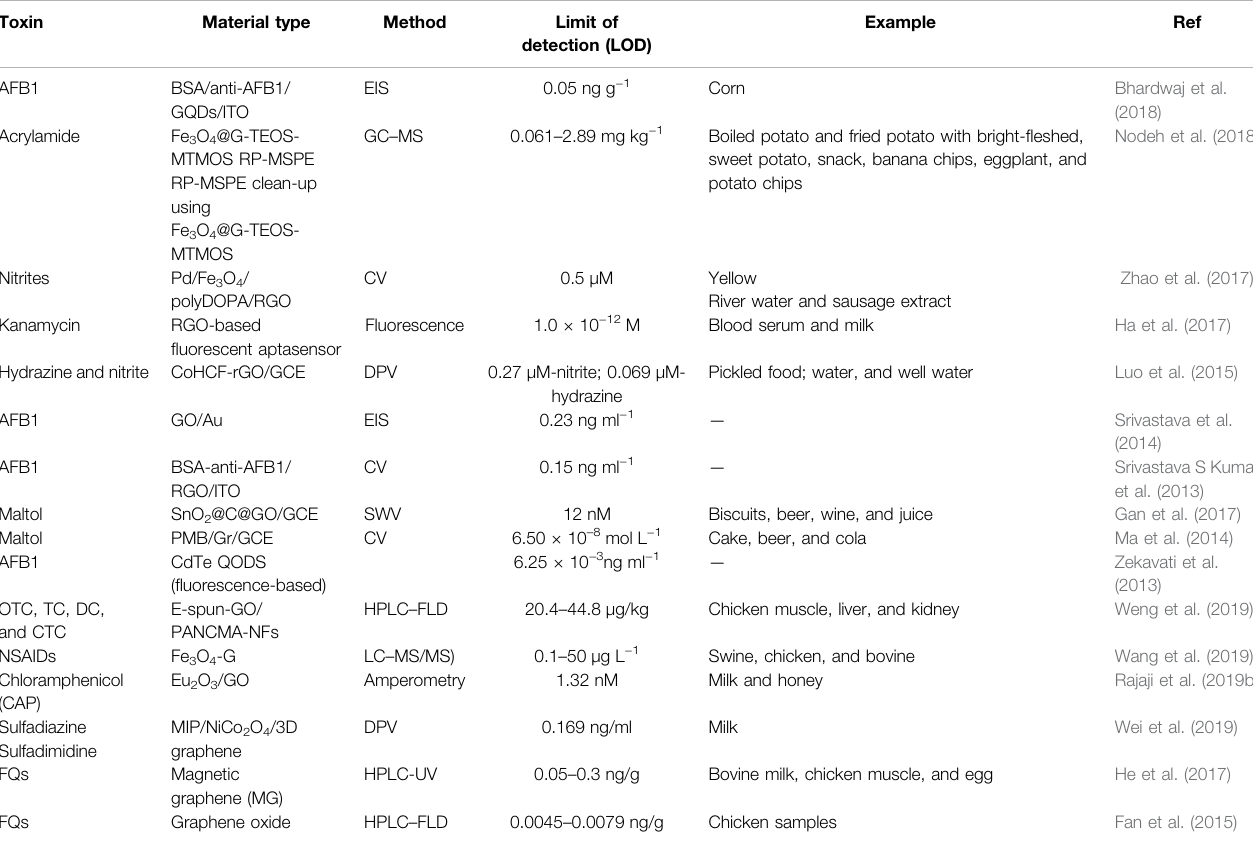
TABLE 3 | Applications of graphene in detecting